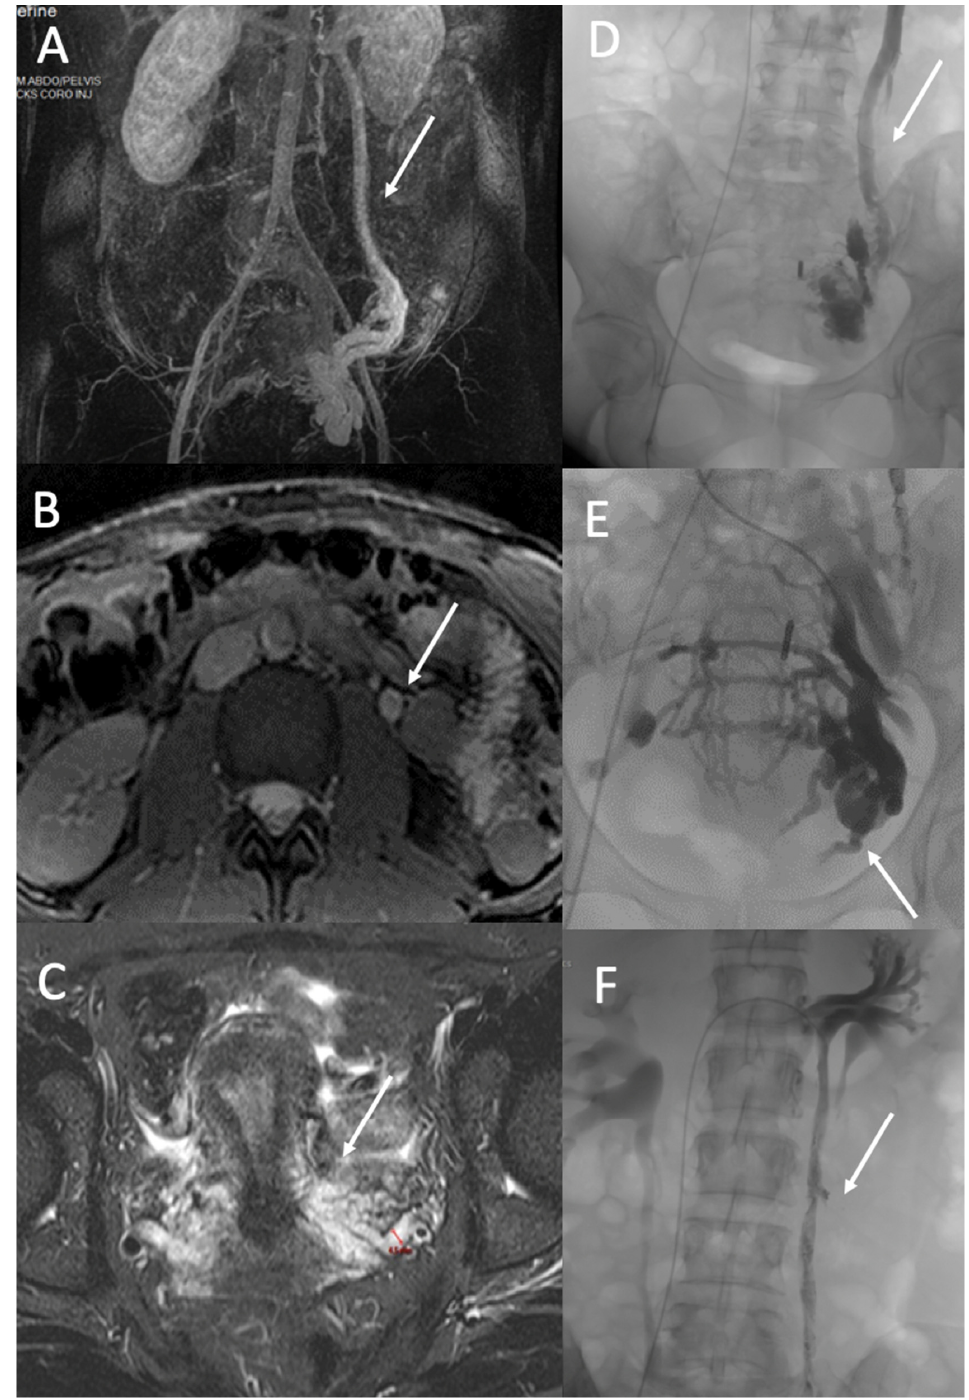
Figure 4. PVD of Zone 2. A 37-year-old woman with a typical pelvic congestion syndrome. ( A ). MR angiography image in the coronal plane shows incompetent and dilated left ovarian vein (arrow) and left pelvic veins with right periuterine varicose vein ( B ). True fast imaging with steady-state-free precession (TRUFI) demonstrated a dilated left ovarian vein (arrow) (10 mm) ( C ), and T2 STIR MR images ( C ) in an axial plane demonstrated dilated pelvic veins up to 8 mm (arrow). Phlebography shows incompetent left ovarian vein (arrow) ( D ) and incompetent internal iliac veins with periuterine and uterine varicose (arrow) ( E ). Treatment consisted of embolization with Onyx and Aetotoxisclerol of ovarian vein (arrow) ( F ) and pelvic